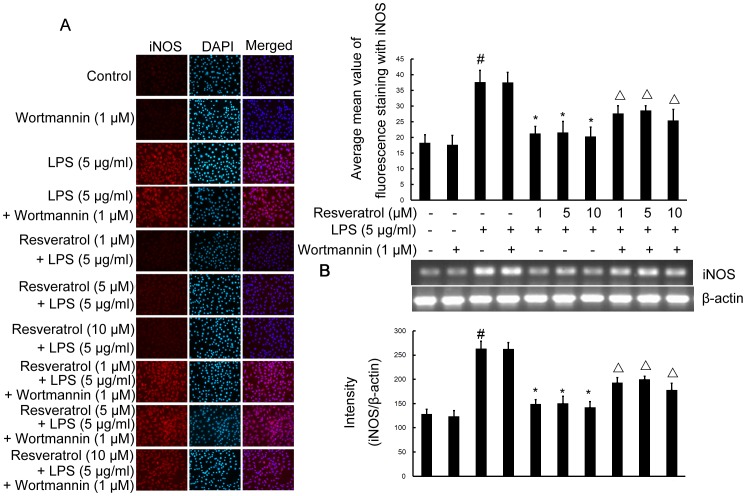
PI3-K is required for resveratrol-inhibited expression of iNOS protein and mRNA induced by LPS in RAW 264.7 macrophage cells.Panel A shows the immunofluorenscence images for protein expression of iNOS and Panel B shows the corresponding mRNA data. The relative mRNA level was quantified by scanning densitometry and normalized to β-actin mRNA. Note the up-regulated protein and mRNA expression of iNOS by LPS is suppressed by different concentrations of resveratrol; however, in cells pretreated with PI3-K inhibitor wortmannin, the suppressive effect of resveratrol is abrogated. The values shown are mean ± SEM of data from three independent experiments. #Significant compared with control alone, p<0.05. *Significant compared with LPS alone, p<0.05. ΔSignificant compared with resveratrol + LPS, p<0.05.